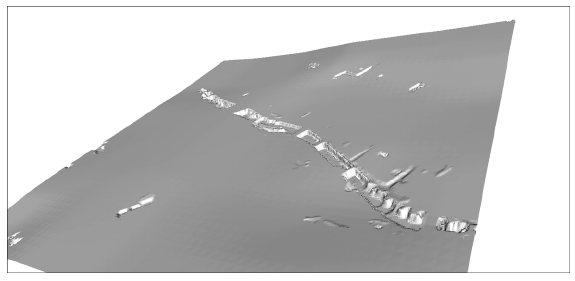
Figure 11. Corrected DTM using OSM